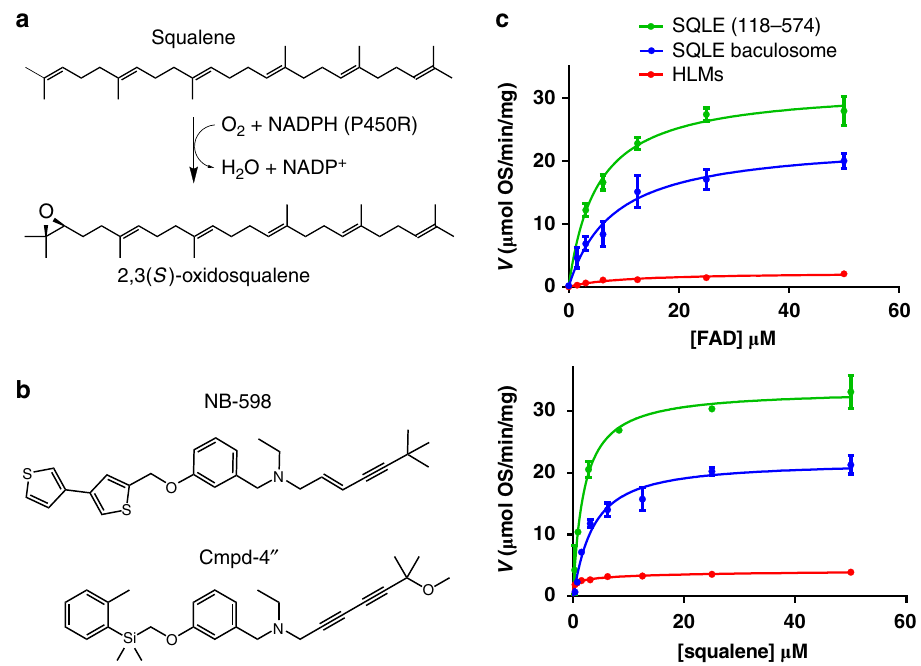
Fig. 1 Structure of SQLE inhibitors and biochemical characterization of SQLE reaction. a Biochemical reaction catalyzed by SQLE. b Structures of SQLE inhibitors NB-598 and Cmpd-4 ′′ . c Steady-state parameters for squalene and FAD af fi nity. Three experimental systems utilized correspond to the recombinant N-terminally truncated SQLE (118 – 574), baculosome membrane preparations from Sf9 cells overexpressing full-length SQLE, and human liver microsomes (HLMs) with endogenous SQLE. Enzyme concentrations were determined by immunoblotting and comparing to a standard curve of recombinant puri fi ed SQLE. Data obtained from enzymatic assays performed with saturating squalene and varied FAD or varied squalene and saturating FAD were fi t to the standard Michaelis – Menten model to obtain K M values for each varied reaction component. Points and error bars denote the mean and standard deviation of triplicate measurements,